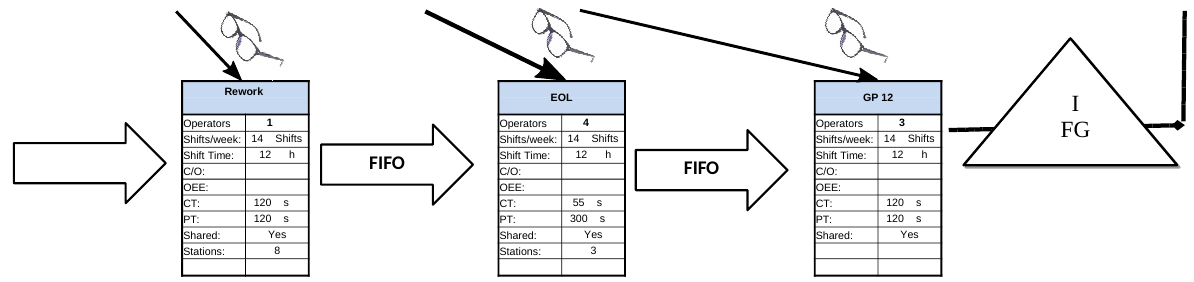
Figure 4. Value Stream Design